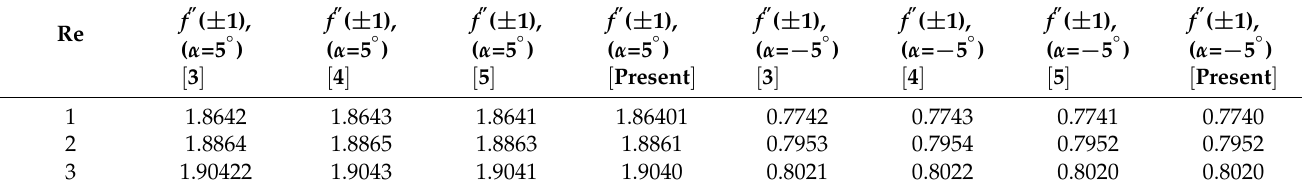
Table 4. Comparison between the present work and previous work considering common parameters